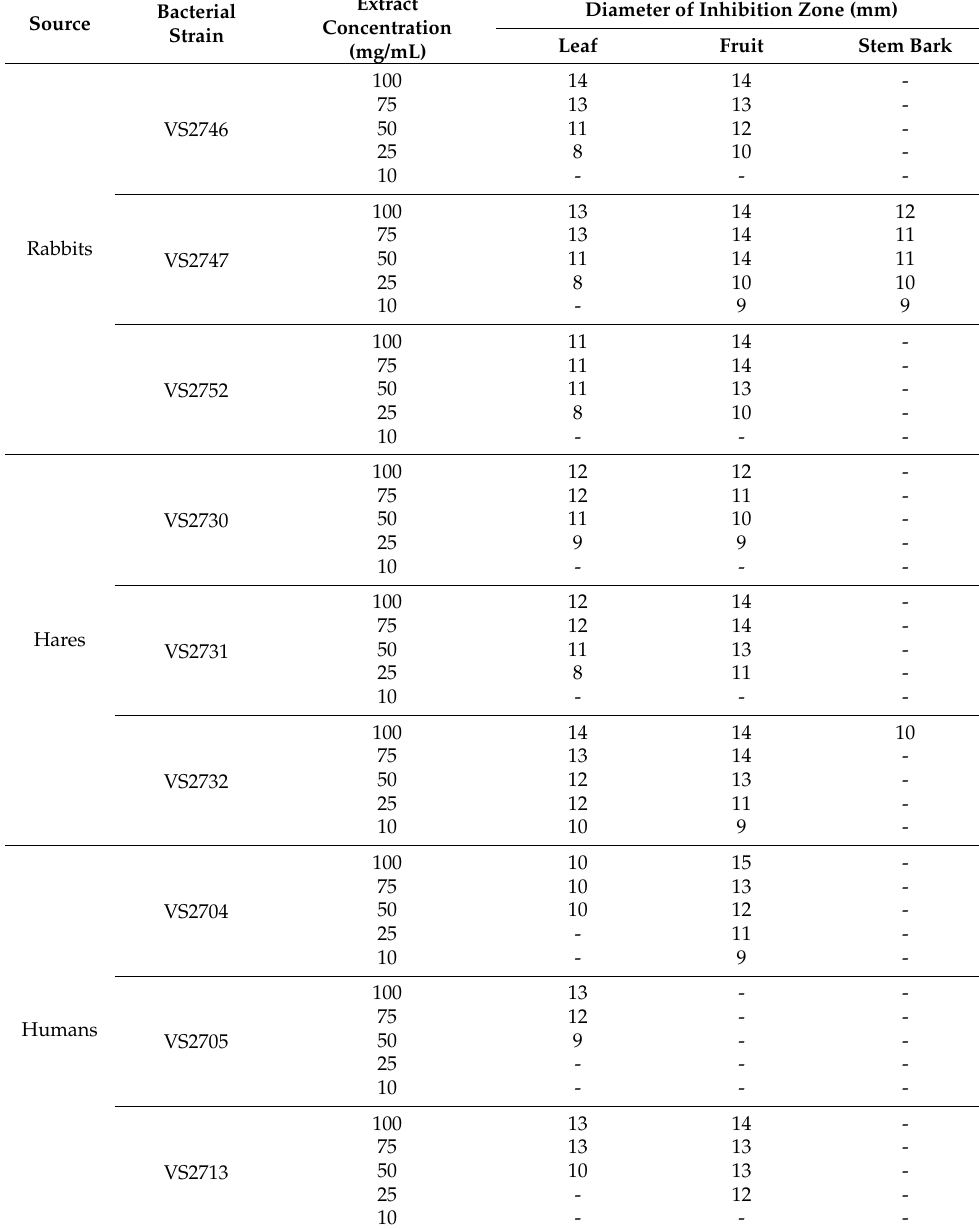
Table 5. The diameter of the inhibition zone (mm) of each extract concentration tested against the nine MRSA strains, obtained by the Kirby–Bauer disc diffusion method.